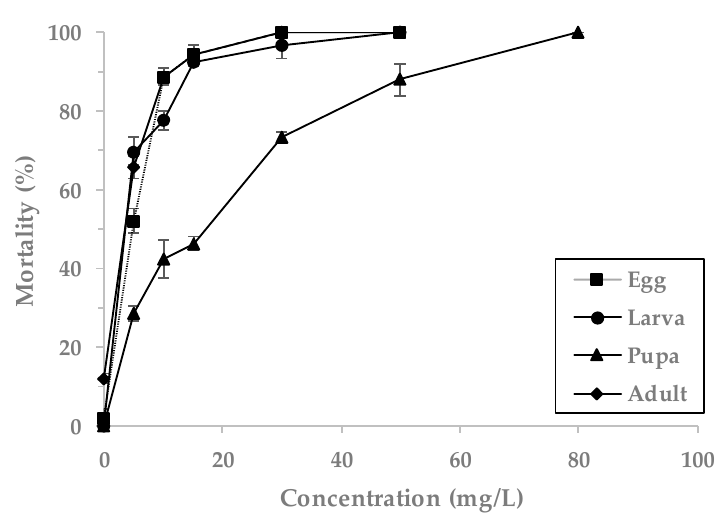
Figure 3. Mortality of L. serricorne exposed to gas mixtures of PH 3 (0.5 mg/L) + EF at indicated concentrations for 4 h at 20 °C in a 55 L desiccator. Table 3. Lethal concentration time of L. serricorne exposed to EF fumigant mixed with PH 3 (0.5 mg/L).